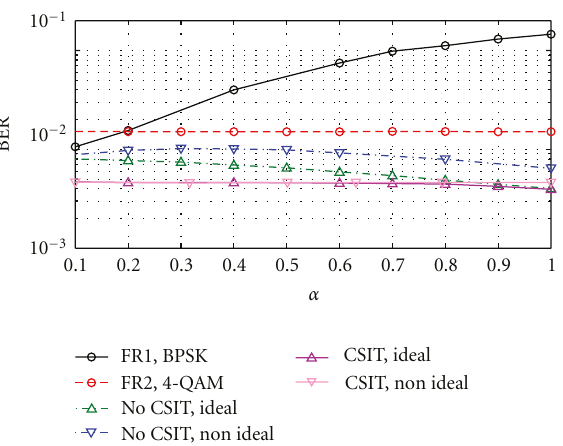
Figure 8: Bit error rate for 4-QAM symbols, as a function of α , 0 . 1 ≤ α ≤ 1, for two isolated base stations and SNR =